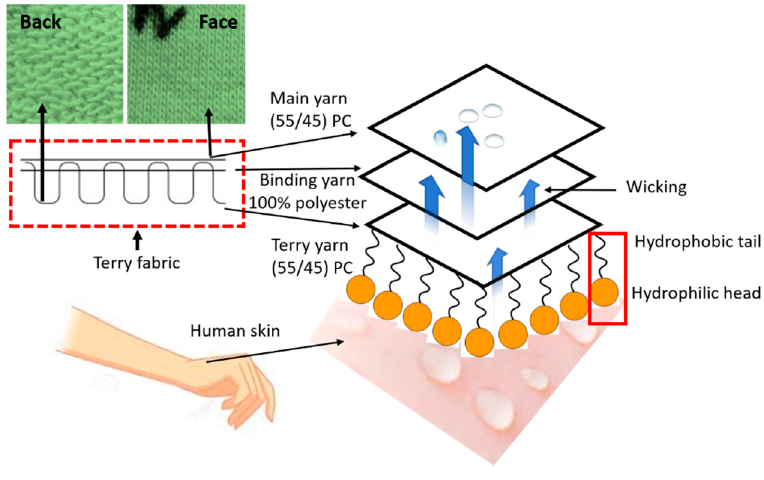
Figure 7. Graphical illustration of the action of anionic softener on moisture management.